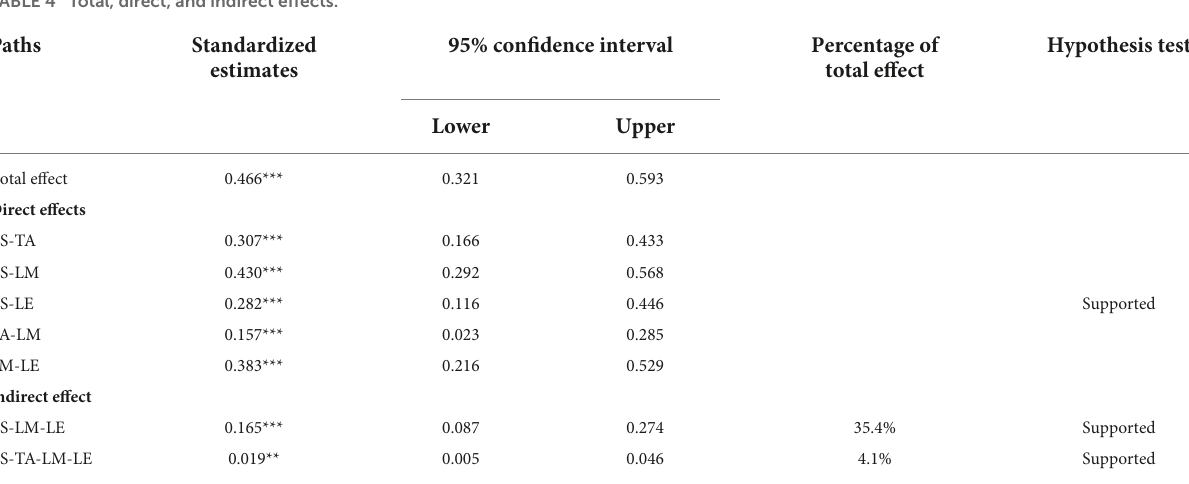
TABLE 4 Total, direct, and indirect